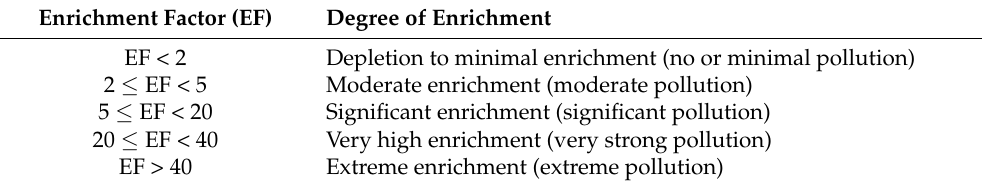
Table 2. Classification of enrichment factor (EF).